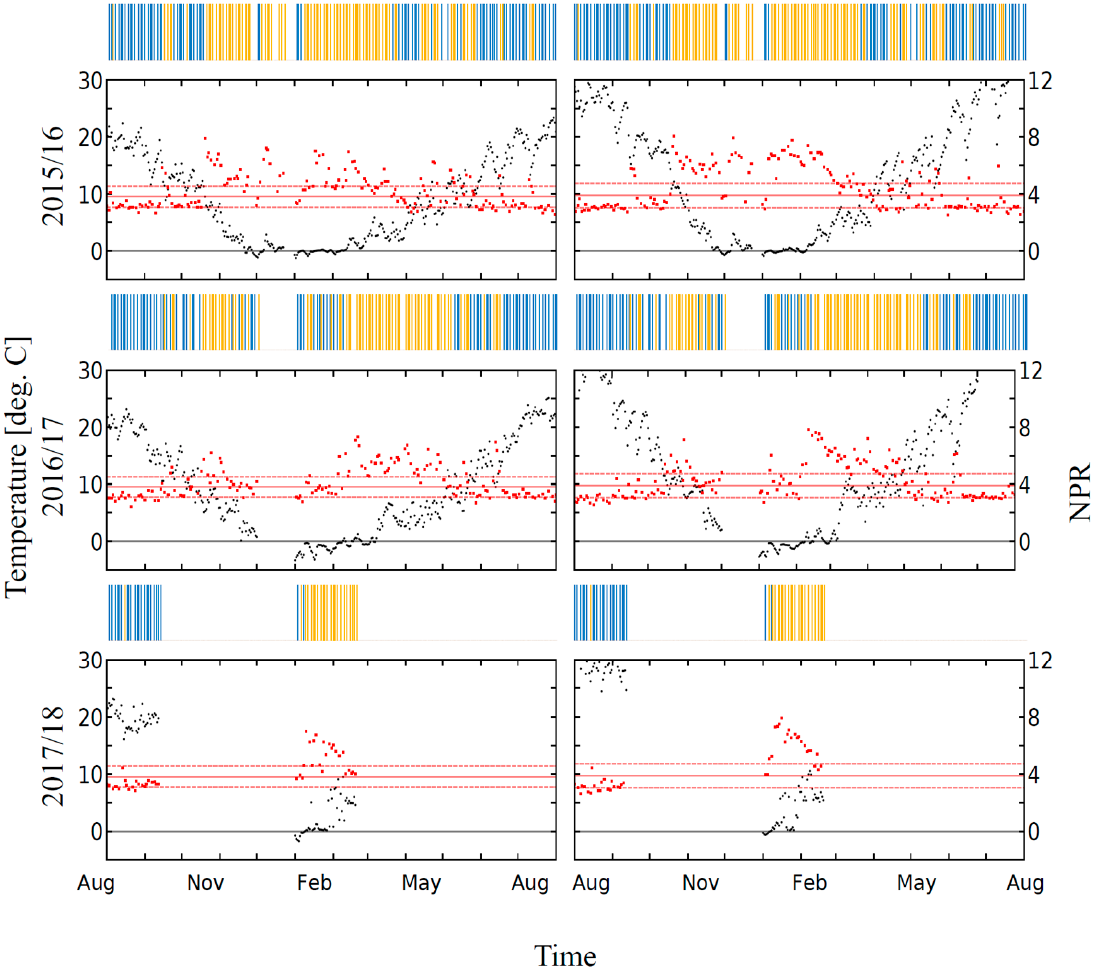
Figure 3. Time series of SMAP NPR (red) and in situ soil temperature (black) at 6 am (left) and 6 pm (right) local time for Idaho (site 0401, grid 60901) for winters 2015/16 ( top ), 2016/17 ( middle ), and 2017/2018 ( bottom ). Here, SMAP data are subset to the in situ data record. The dashed lines bounding the NPR are the reference NPR values for freeze and thaw. The solid line in-between them is the NRP threshold. If NPR(t) is below (above) this line, then the SMAP retrieval is set as frozen (thawed). The SMAP retrieval result is shown in the bars above the time series plot: light brown, blue, and white boxes correspond to thawed, frozen, and missing data, respectively.